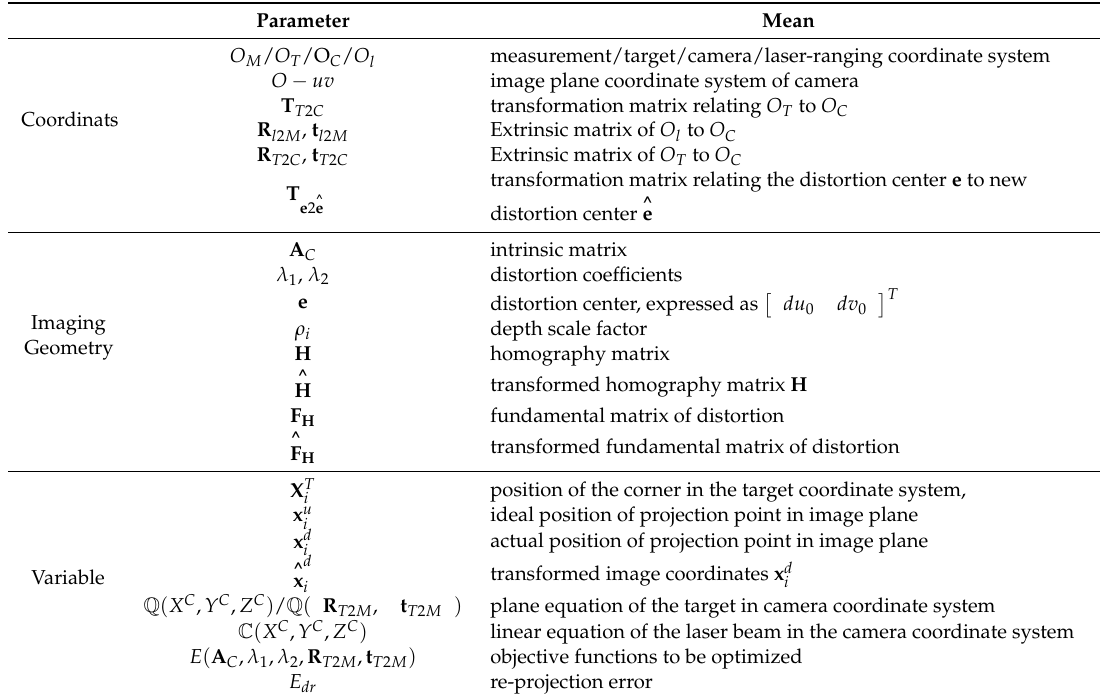
Table 1. The parameter statement of the